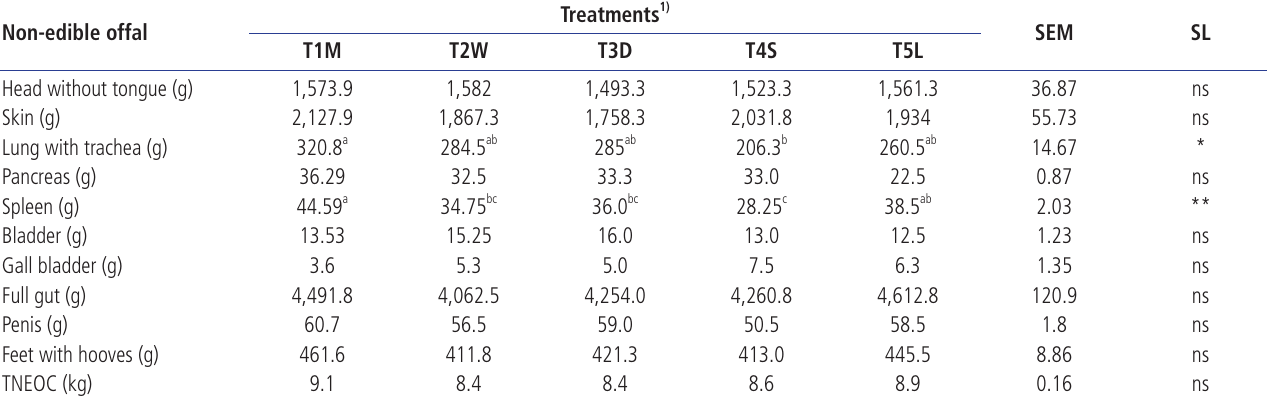
Table 8. Non edible offal components of Arsi-Bale sheep fed diets containing different varieties of faba bean straw (70%) and concentrate (30%) Non-edible